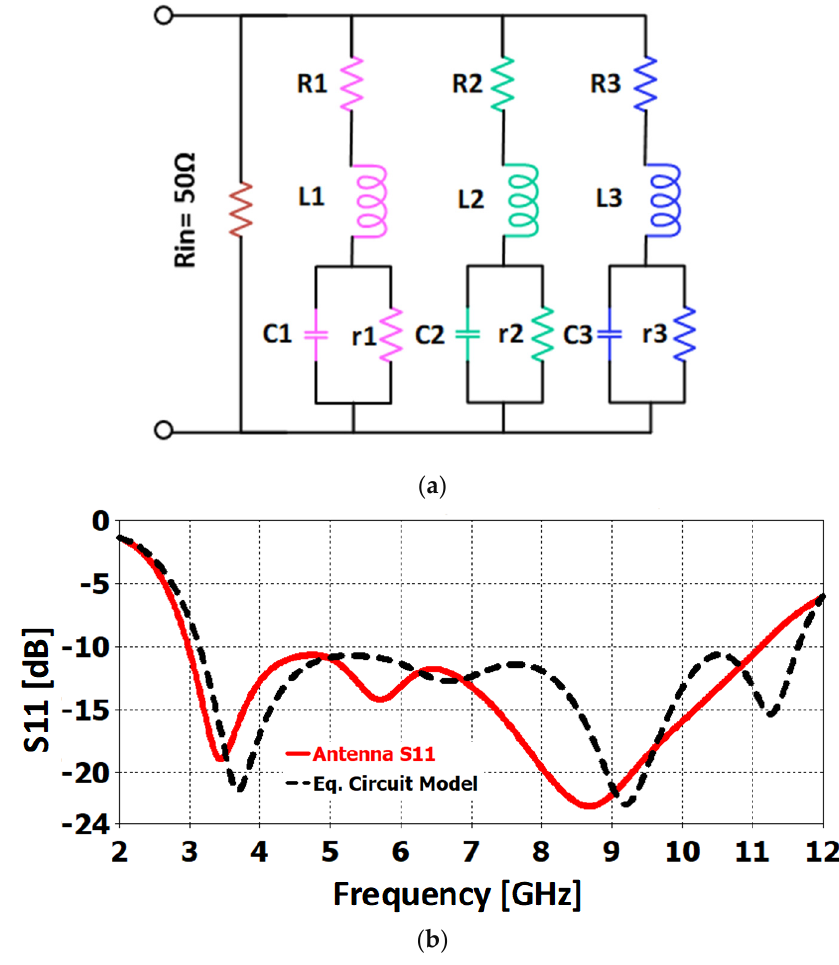
Table 3. Values of the components used in the circuit model.